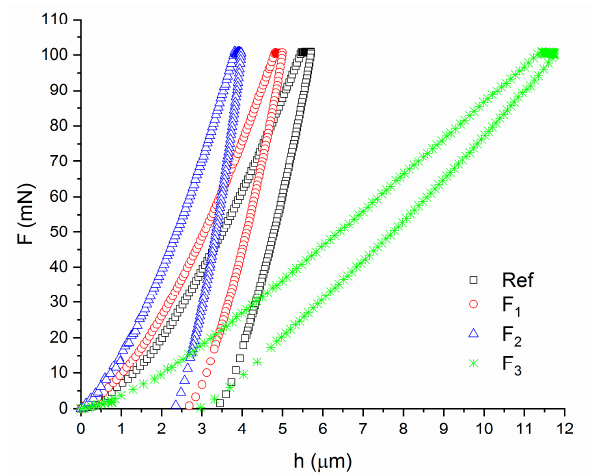
Figure 5. Typical loads vs. indentation depth curves for reference and irradiated PLLA Figure 5. Example of mechanical characteristics of reference and irradiated PLLA specimens.